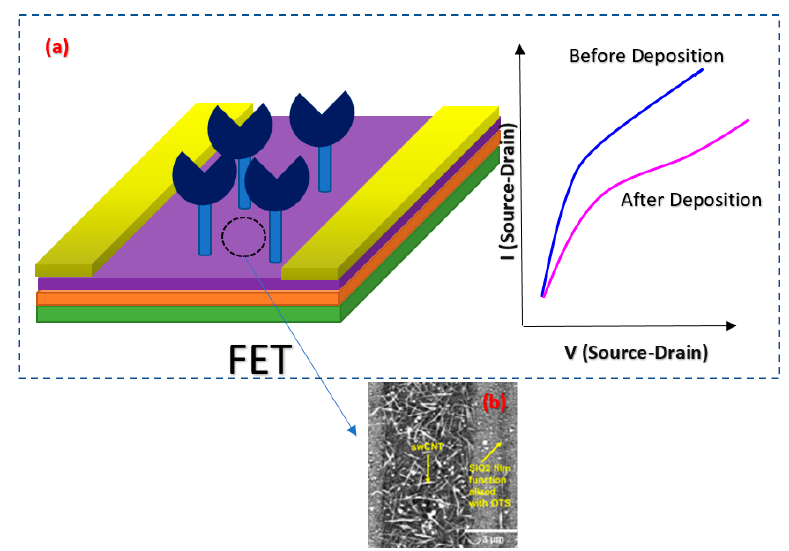
Figure 22. ( a ) Electrical identification of the viral particles using a tailor-made single-walled car- bon nanotube (SWCNT)-FET immunosensor; ( b ) AFM image of the SWCNT channel